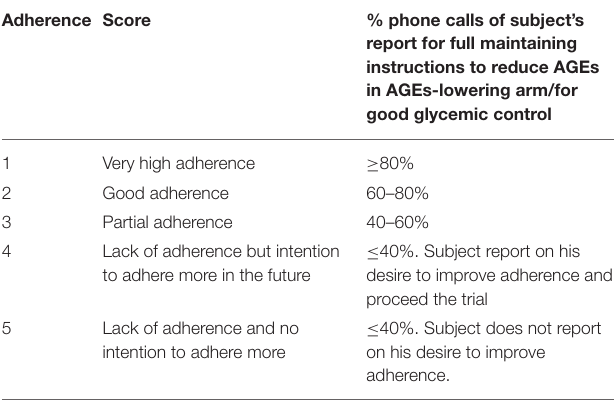
TABLE 2 | Adherence scale with dietary guidelines. Adherence